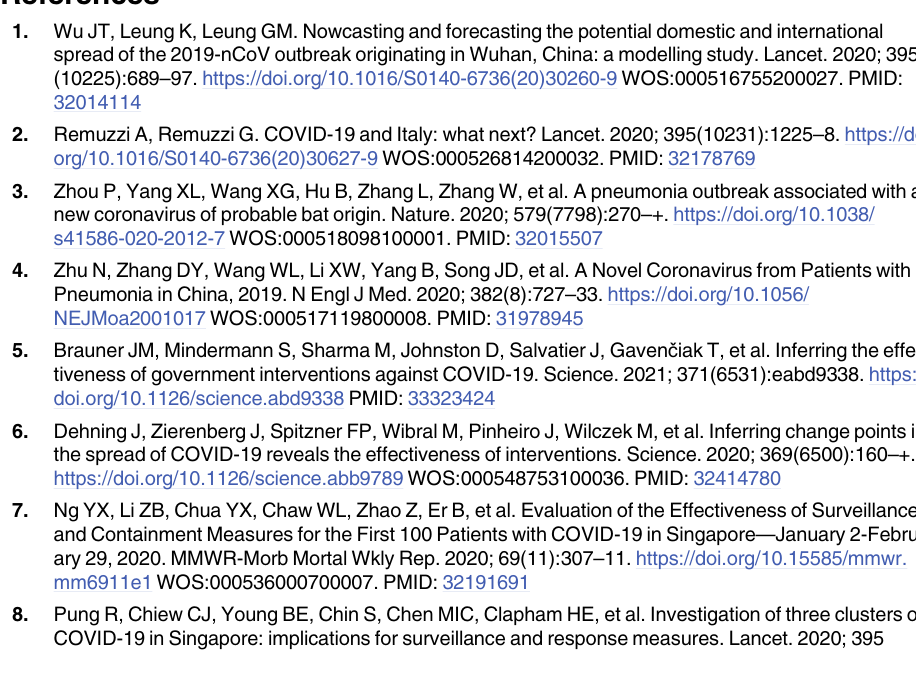
S3 Fig. Sensitivity analysis. The plot shows how much R changes from a 10% increase (red) t or 10% decrease (blue) in that model parameter relative to values in Table 1 (with τ = 0.2 and Is κ = 1). R t scales linearly with β and κ , whereas transition parameters q E ! Ips , q Ips ! Is , the testing rate τ , and pre-symptomatic infectiousness σ have approximately 50–75% as large an effect Is Ips as β or κ . The recovery rate, γ , and symptomatic infectiousness σ are less influential, and the Is Is death rate α has very little effect on R Is t